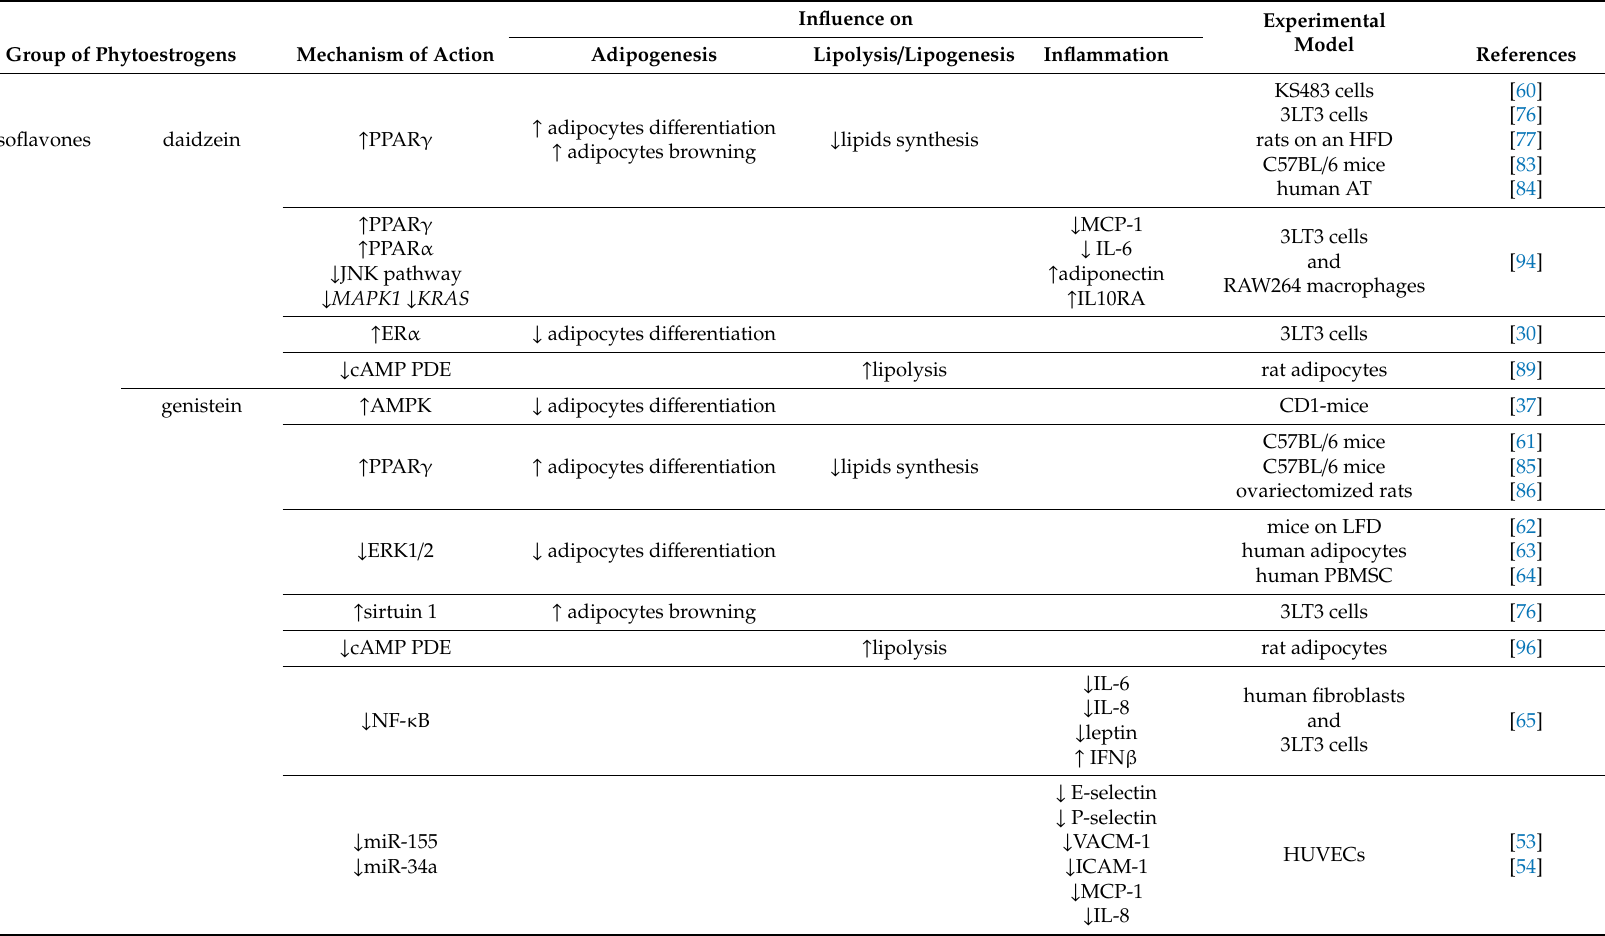
Table 1. Influence of phytoestrogens on adipose tissue development, metabolism, and secretory